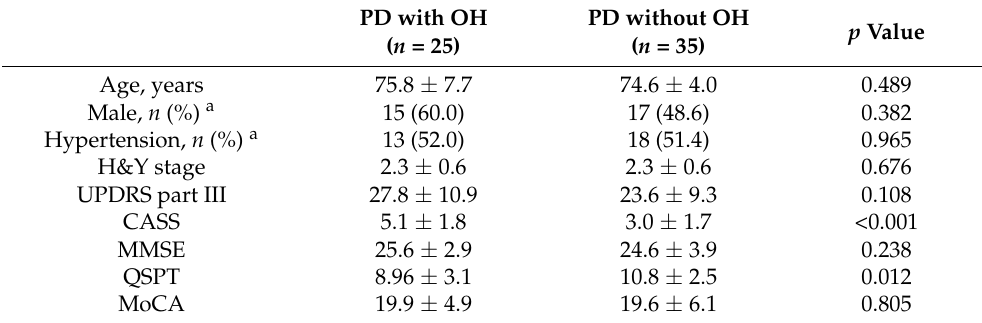
Table 1. Demographic and clinical characteristics of the patients.